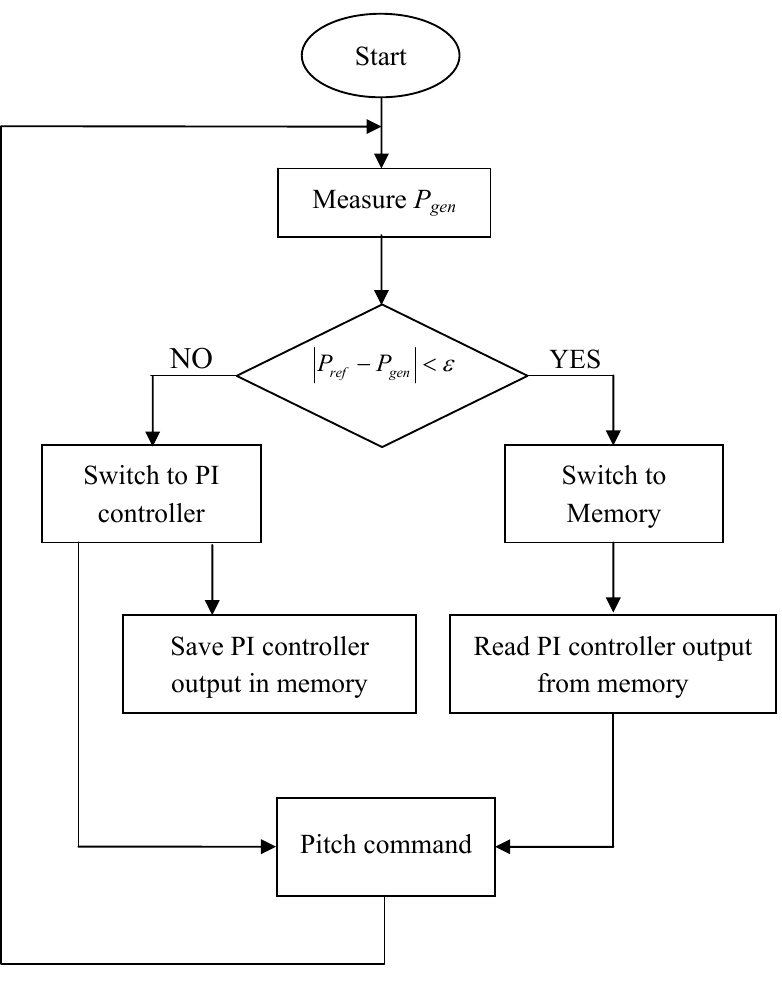
Figure 6. Flow chart of the PI pitch fluctuation